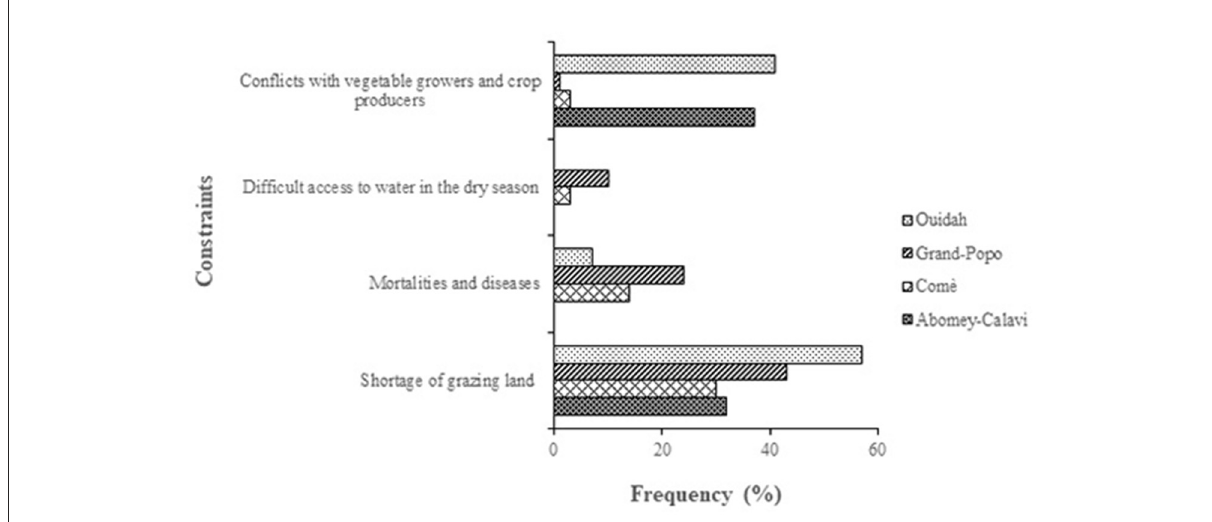
FIGURE7 Main constraints (on vertical axis) of dairy cattle farming across four peri-urban locations in south